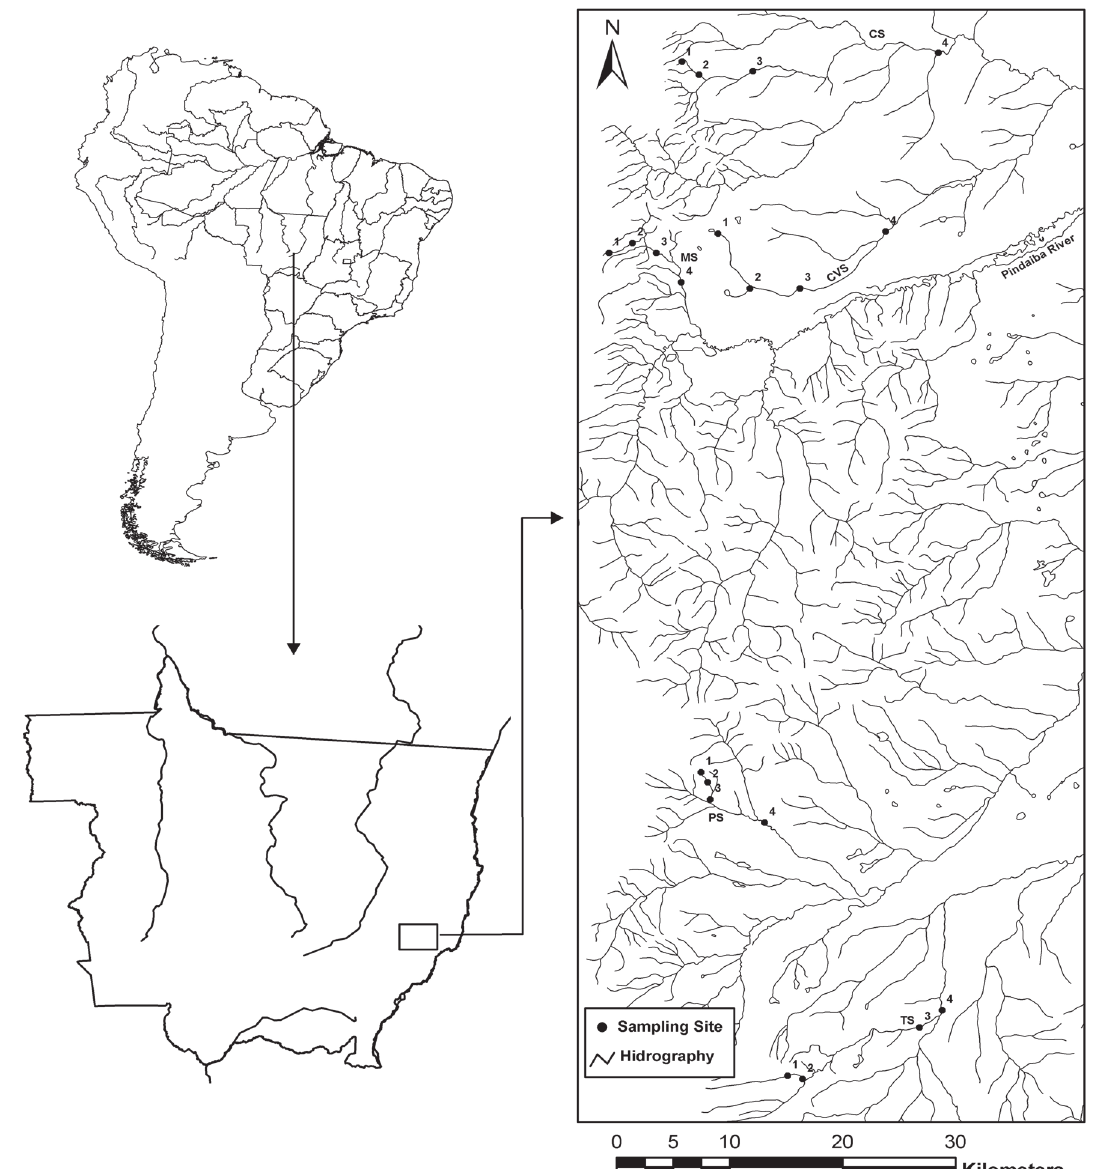
Figure 1. Study sites location in the Basin Pindaíba River, Mato Grosso,